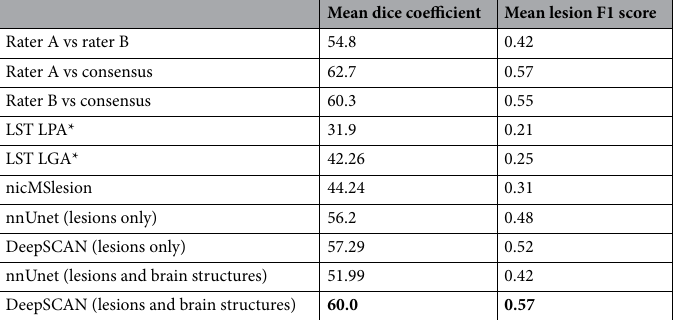
Table 2. Segmentation and lesion detection metrics on the Insel32 dataset, together with inter-rater statistics. Methods labelled * were not trained on the Insel90 dataset, and are provided for